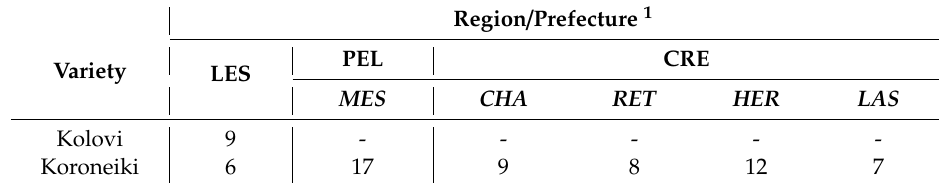
Table 3. Number and coding of Greek olive oil samples according to cultivar and geographical